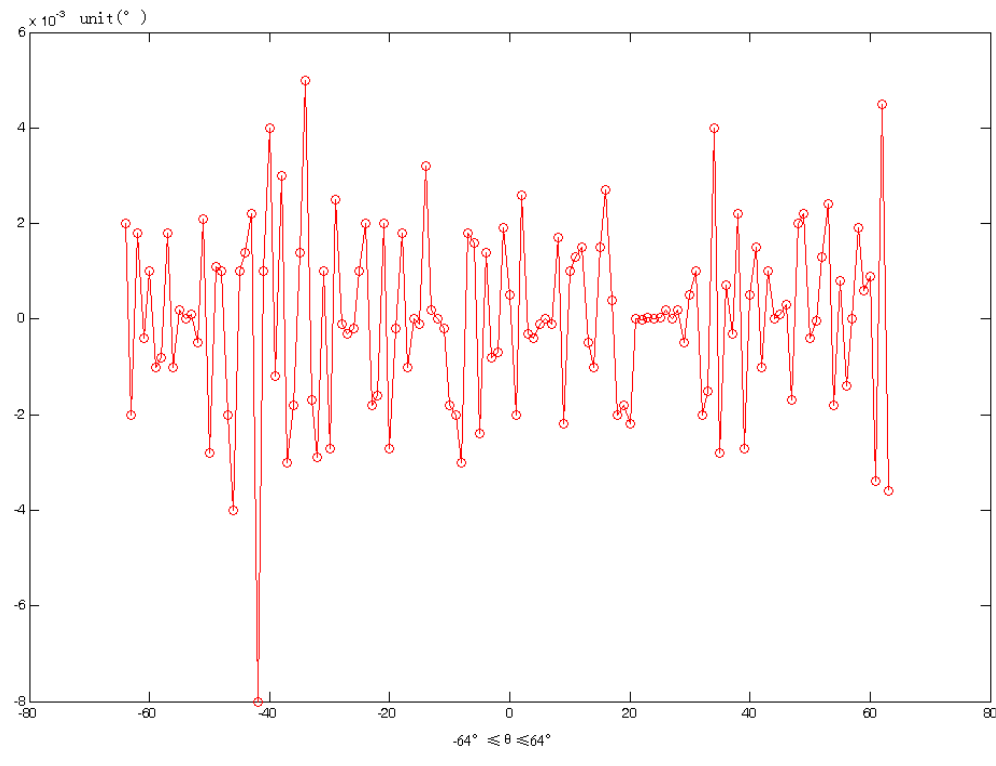
Figure 13. The accuracy of a sun sensor with incident angle in the range of − 64° to +64°. (a) x axis result, (b) y axis